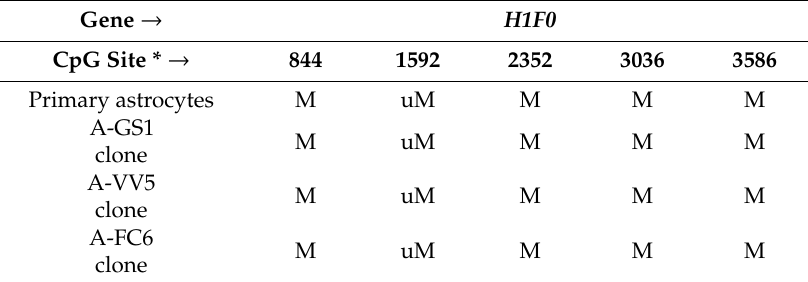
Table 2. Promoter CpG methylation of H1F0 , in the four cell populations.